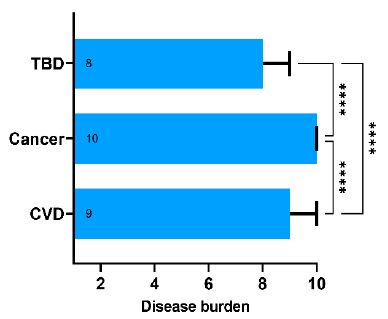
Figure 2. The subjective disease burden assessed using the 10 ‐ point Likert scale ranging from 1— “does not affect the human health” to 10—“poses significant public health burden”. Data presented as medians (boxes) and interquartile range (whiskers). The annotations within the bars represent the median values. **** represent p ‐ value below 0.001 calculated with the one ‐ way ANOVA fol ‐ median values. **** represent p -value below 0.001 calculated with the one-way ANOVA followed lowed by Tukey’s multiple comparisons test. Abbreviations: TBD, tick ‐ borne diseases; CVD, cardi ‐ by Tukey’s multiple comparisons test. Abbreviations: TBD, tick-borne diseases; CVD, cardiovascu- ovascular diseases . lar